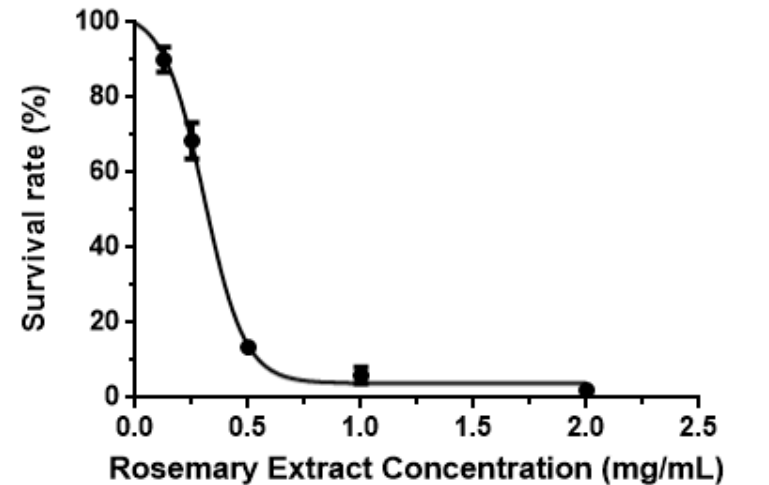
Figure 5. Survival rates of MCF-7 cancer cells treated with different levels of RE.